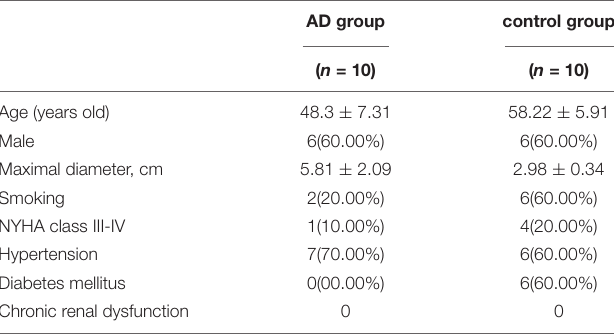
TABLE 1 | Information of aortic dissection and ischemic heart disease patients.